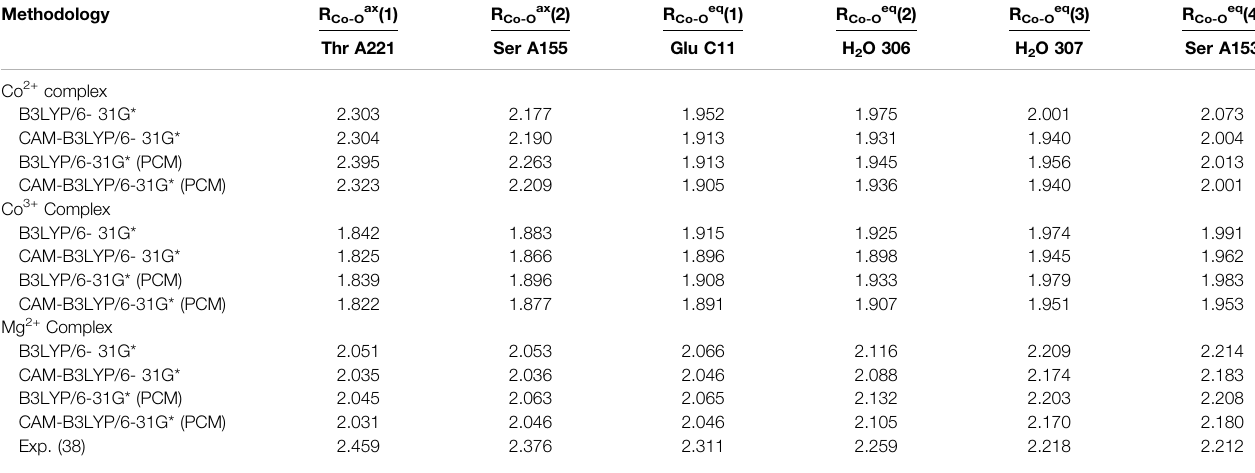
TABLE 2 | Axial and equatorial bond lengths in Å for the collagen-integrin model complexes discussed in this study.